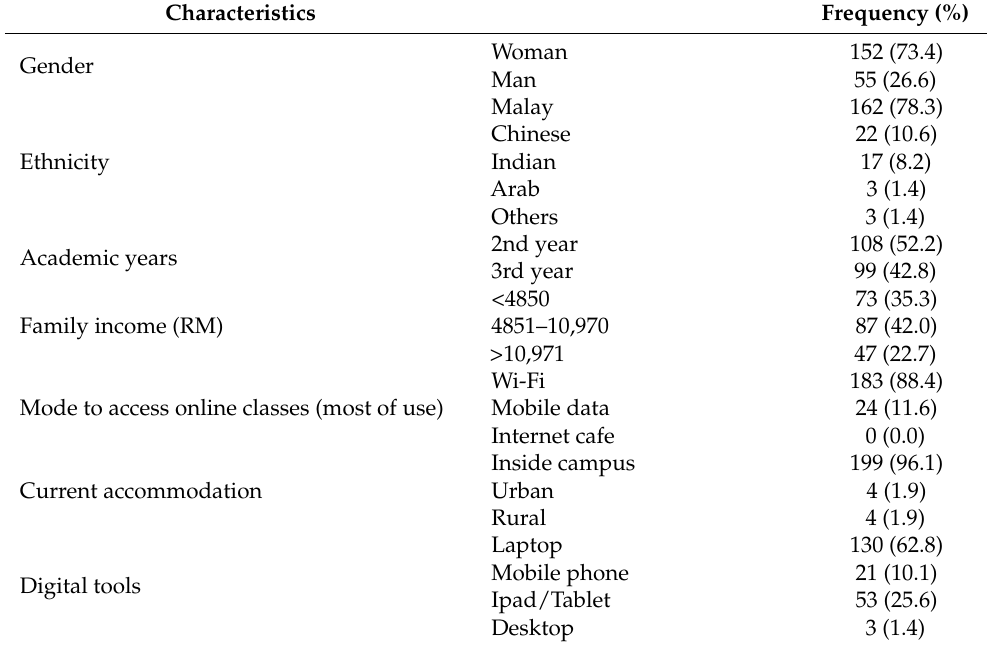
Table 1. Demographic characteristics of the participants (n =